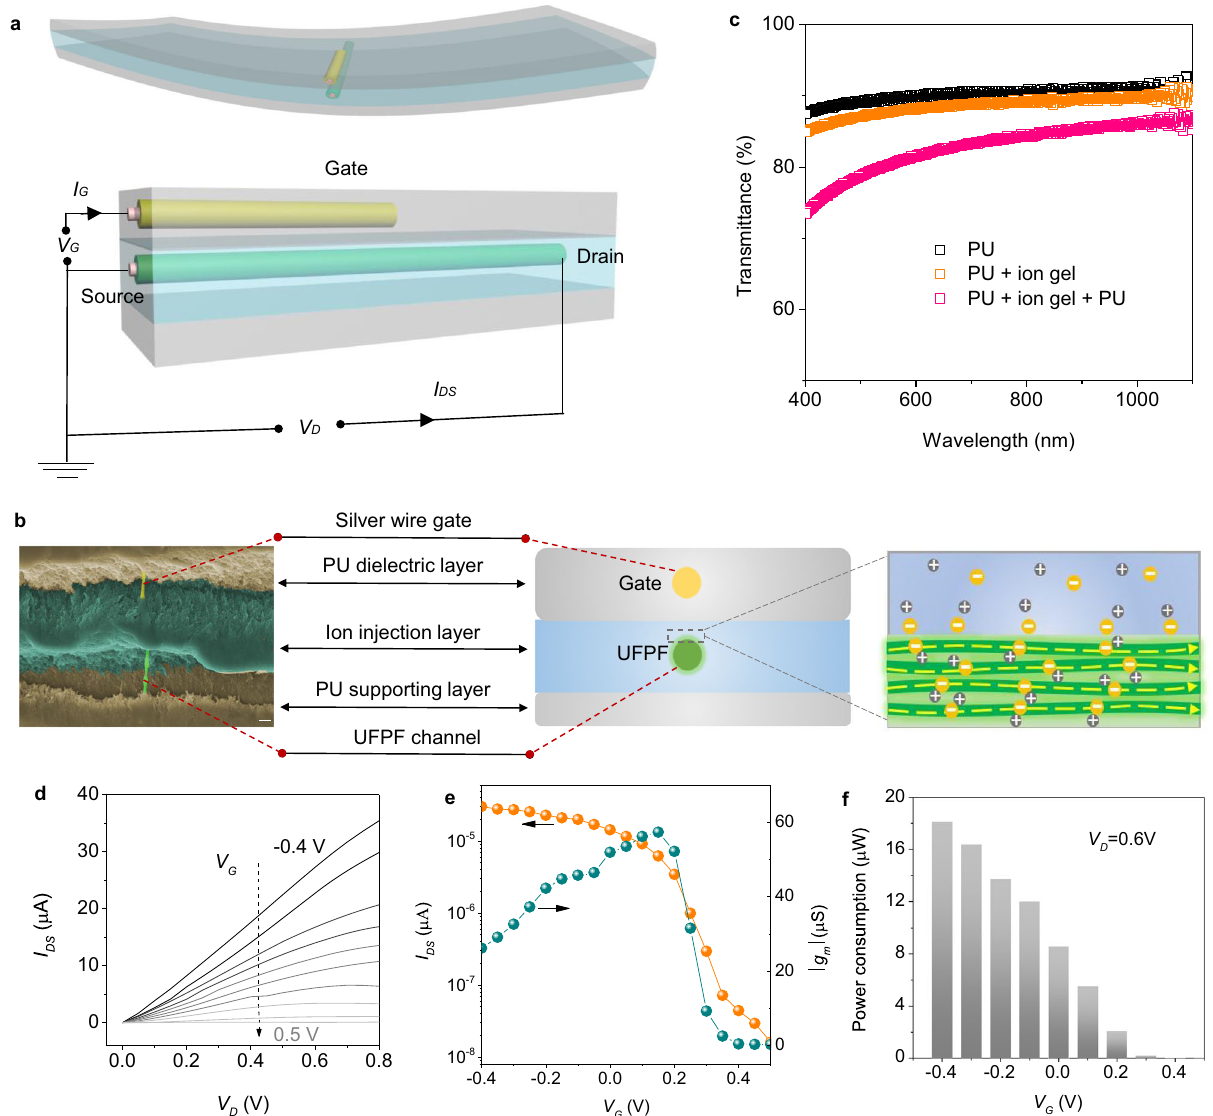
Fig. 4 Demonstration and characterization of all-solid organic electrochemical transistor based on UFPFs. a Schematic of the all-solid OECT composed of three polymer layers, one silver wire as the gate electrode, and one UFPF as the drain-source channel. b Cross-section SEM image and schematic of OECT. The yellow break lines direct the charge fl ow along the fi ber chains (green solid lines). c Transmittance of the OECT in the region of visible light. A typical output curve ( d ), transfer curve ( e ), and power consumption in operation ( f ) of OECT. Scale bars: b 20 µ